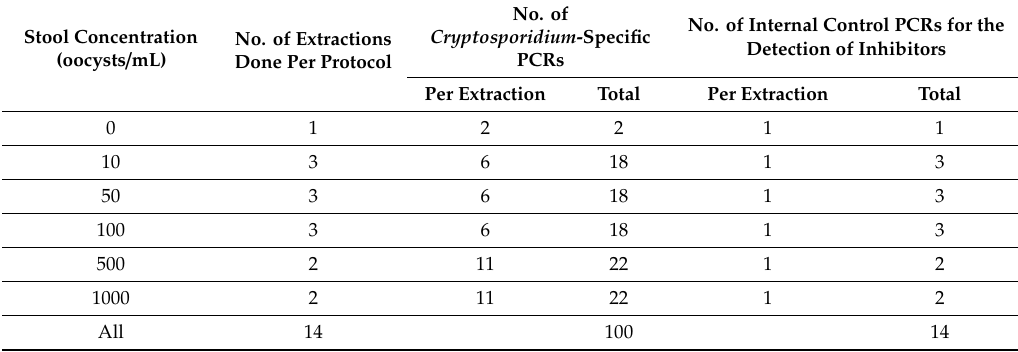
Table1. Designofthestudy: numberofDNAextractions, Cryptosporidium -specificPCRs, internalcontrol PCRs for the detection of inhibitors, according to the parasite concentration for each protocol. Stool Concentration (oocysts /